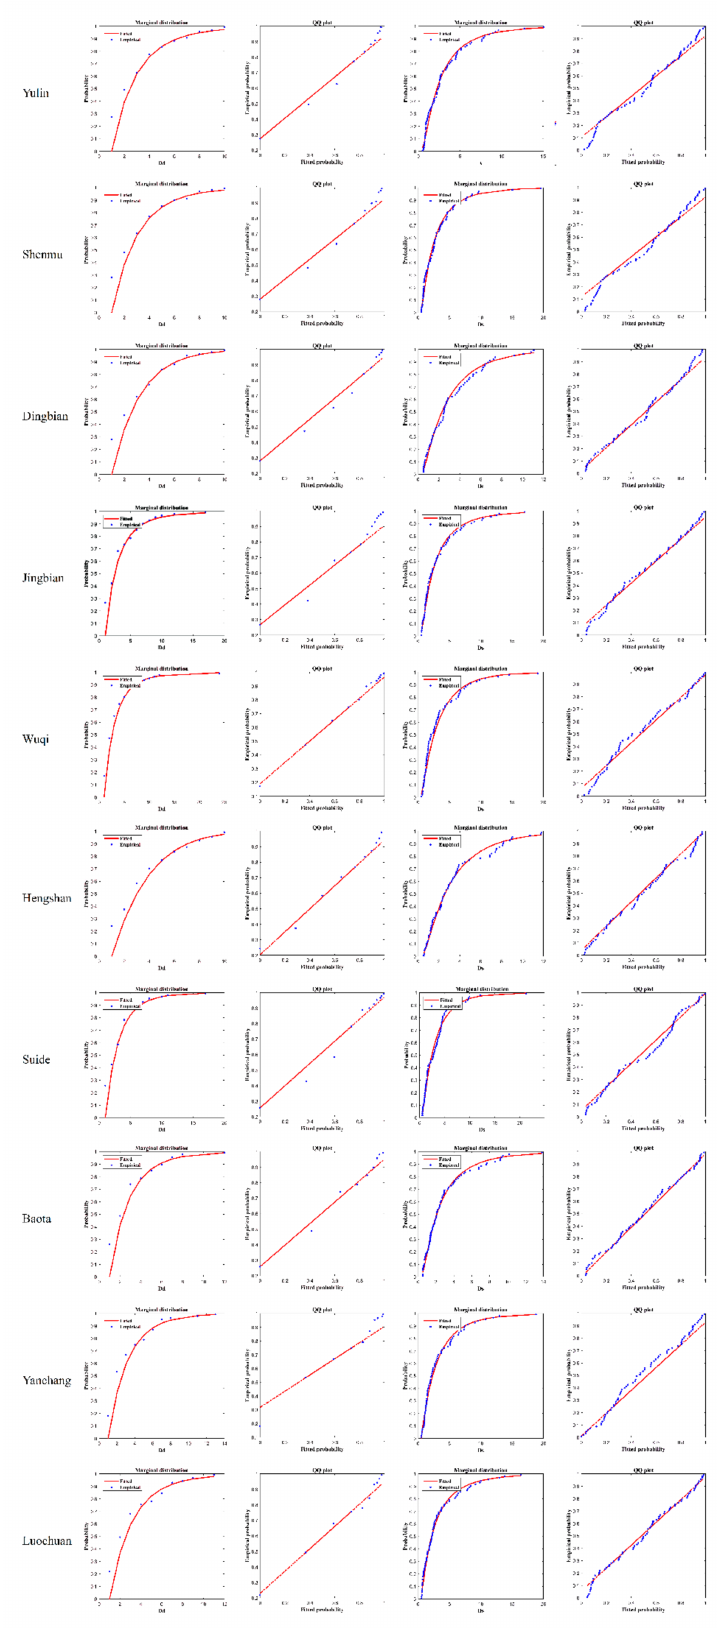
Figure 4. The marginal distribution fitting and quantile-quantile (Q-Q) plots of 10 stations drought variables from 1960 to